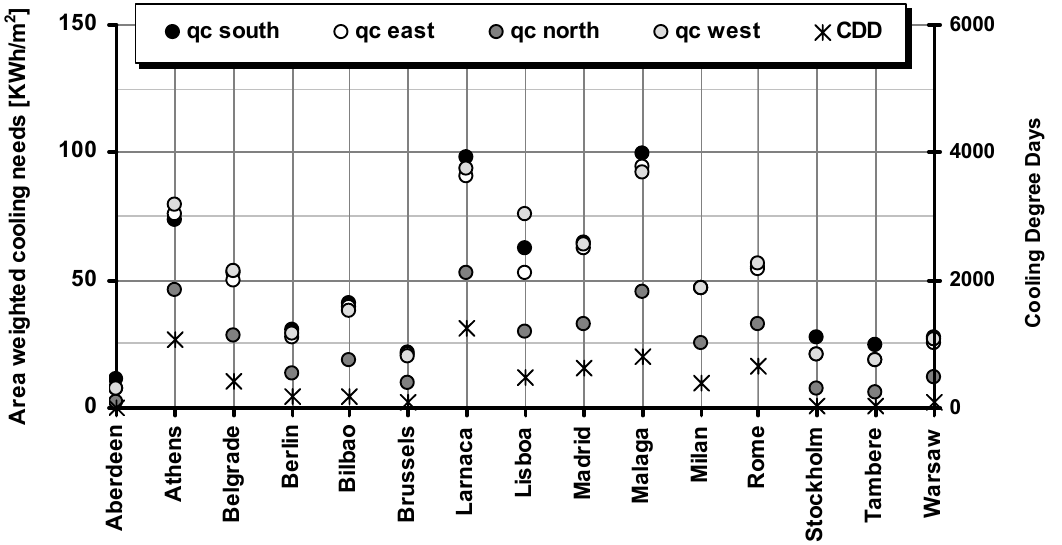
Figure 7. The area weighted cooling needs of the building unit located in the 15 selected cities, with regard to their amount of Cooling Degree